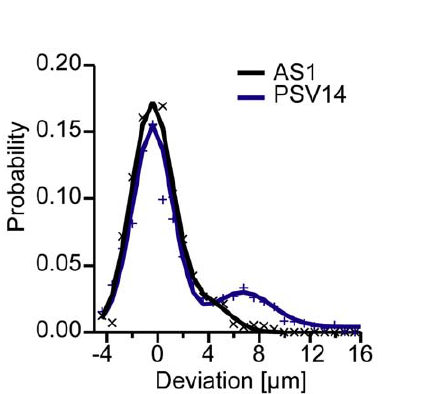
Figure 7. Symmetry break of cells. Degree of cell deformation of a single, representative 1AS cell (black line) and a ASpSV14 cell (blue line) with respect to the direction of cell motility.